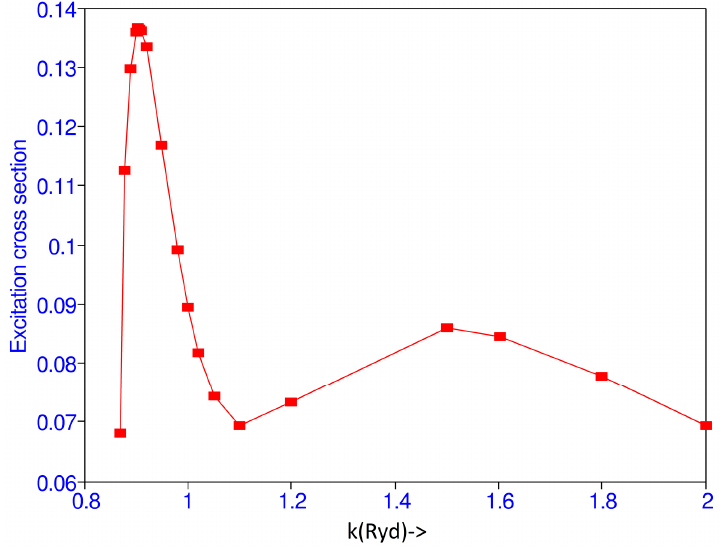
) vs. the incident momentum k 0